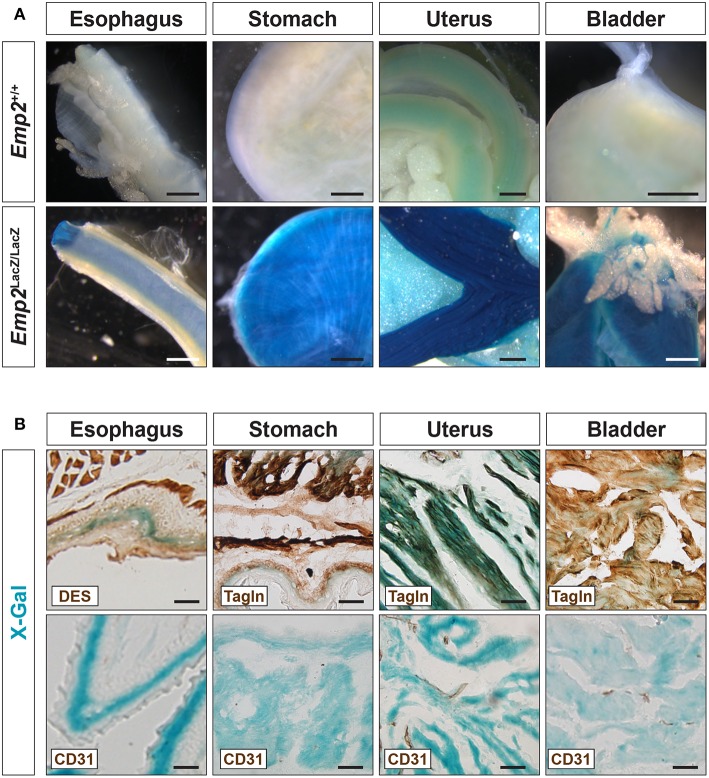
Emp2 is expressed in smooth muscles. (A)
Emp2 is expressed in non-vascular smooth muscles. Strong β-gal histochemical staining of the esophagus, stomach, uterus, and bladder of Emp2lacZ mice. Scale bars: 1 mm. (B) Immunohistochemical staining reveals that the Emp2 expression is overlaps with Des+ (esophagus) and Tagln+ (stomach, uterus, and bladder) smooth muscles but not to CD31+ endothelia. Scale bars: 200 μm.